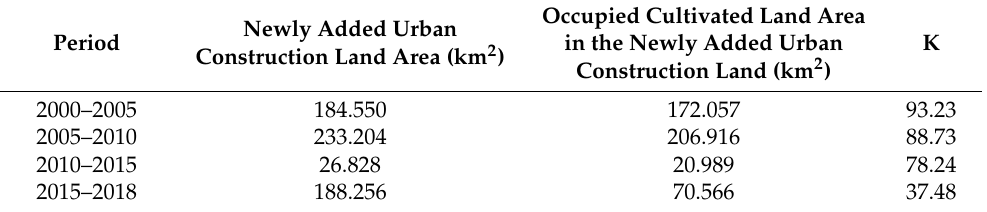
Table 2. Statistics on urban expansion dynamics occupying cultivated land from 2000 to 2018.